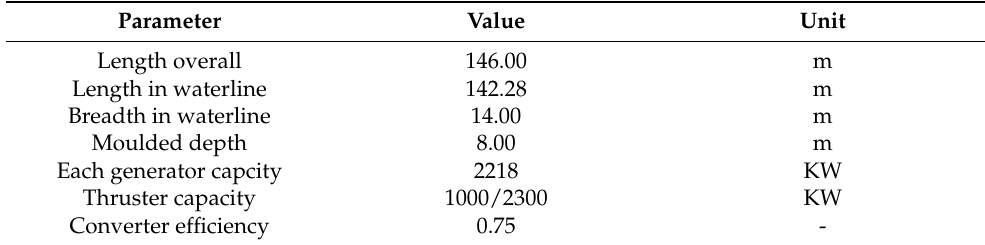
Table 1. Ship important parameters.